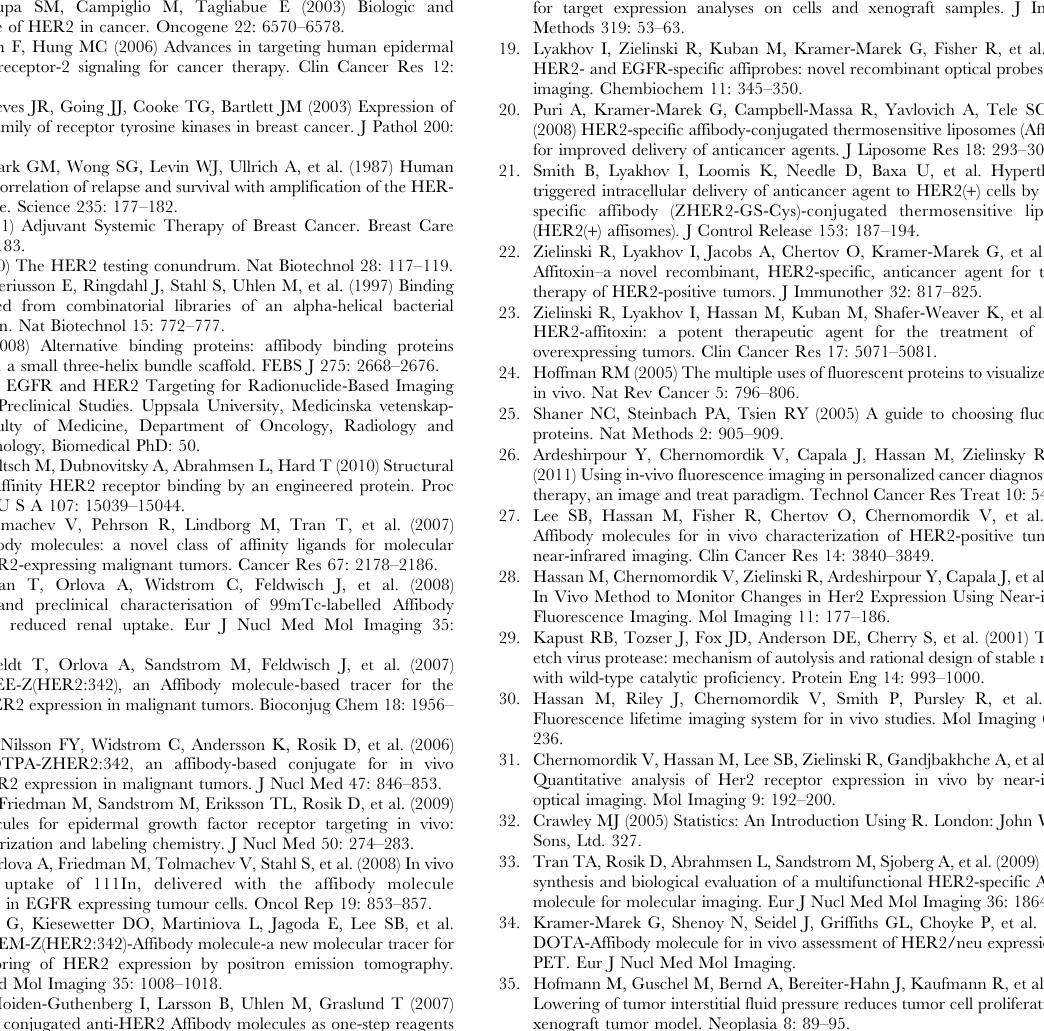
conjugate. Series images were taken every second for 1 min, followed by 2-hours imaging with two frames per minute. During imaging mouse was kept at shallow anesthesia (1%, isoflurane) and sacrificed after the imaging was